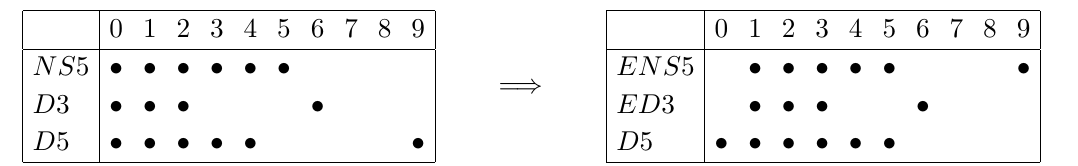
Table 1 . Left table : ABJ(M) setup in IIB string theory. The Lorentzian 3D CFT is in the 012 direction. Right table : analogous setup to ABJ(M) in IIB (cid:0) + Euclidean 3D CFT is in the 123